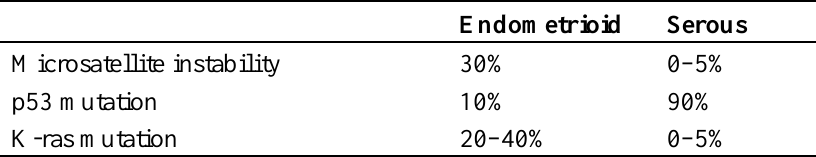
Table 2. Molecular aspects of uterine endometrioid and serous